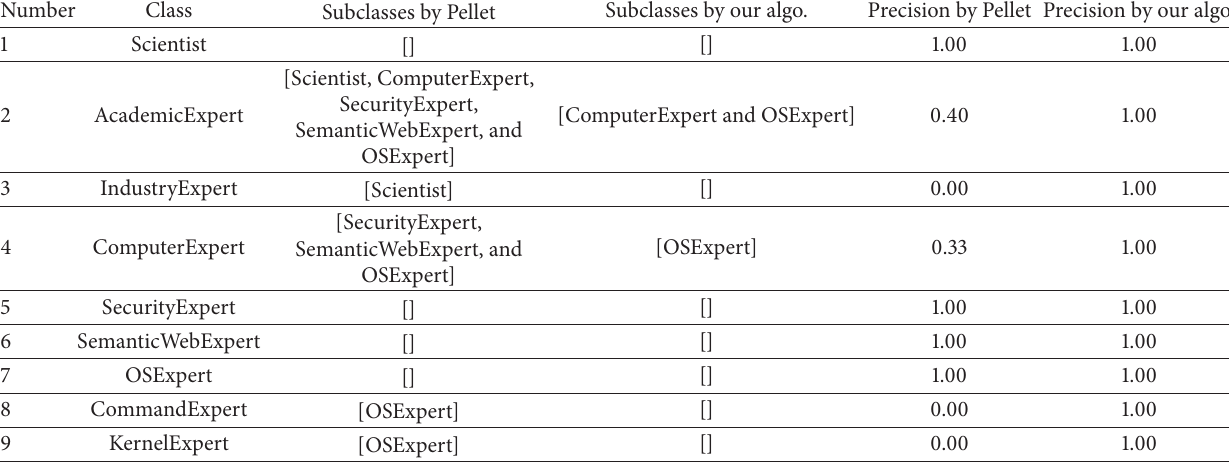
Table 10: Conference cases subclass calculation results: